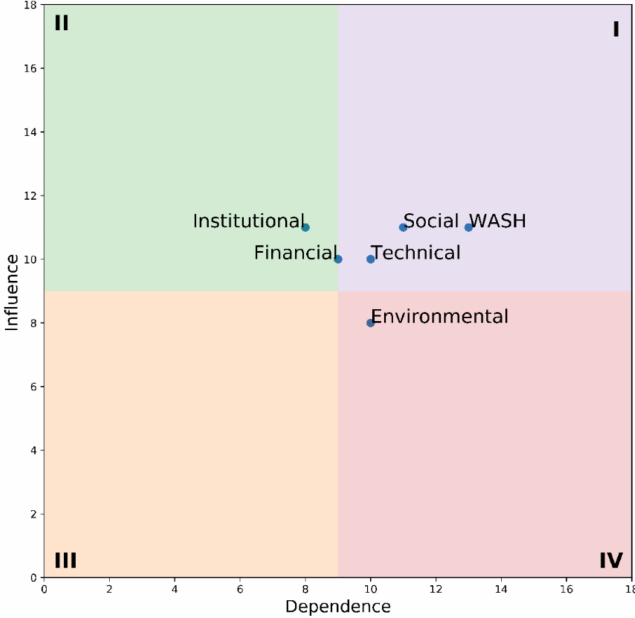
Figure 2. Influence-dependence map from the cross-impact